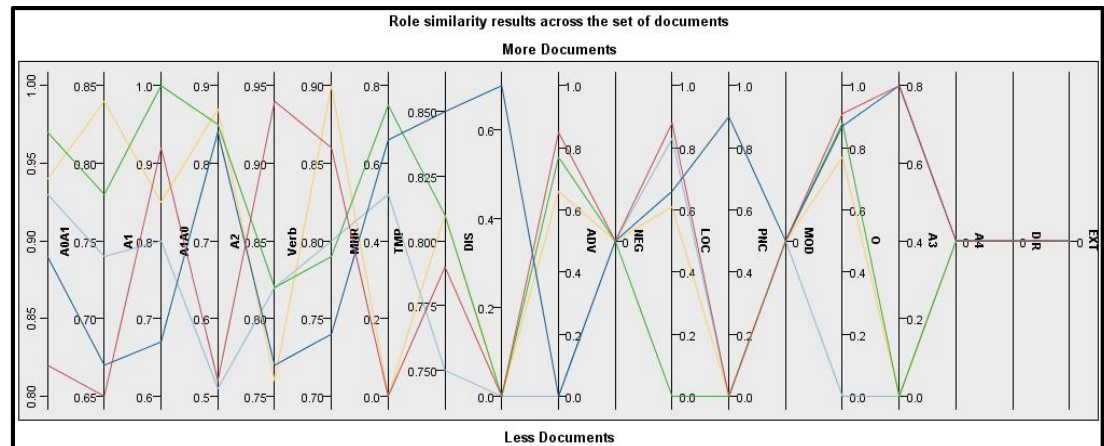
Figure 8. Role similarity scores across the set of